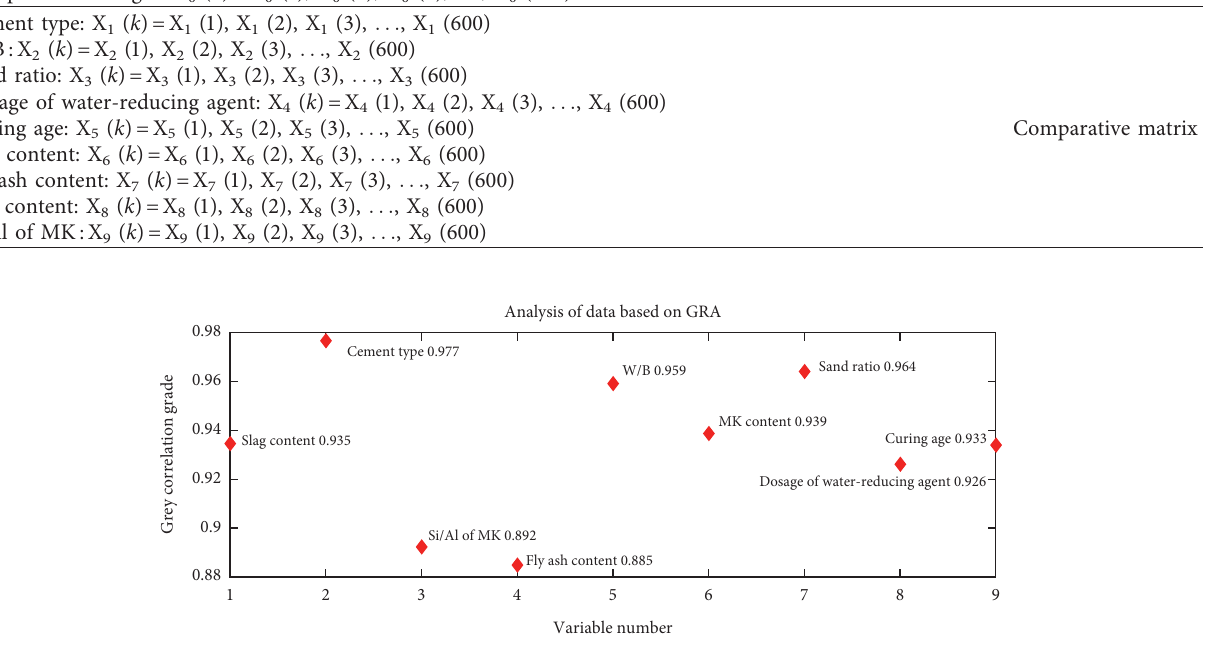
Figure 2: The grey correlation grade values of nine factors. Table 4: The characteristics of dataset (600 groups of data selected from 18 research articles).